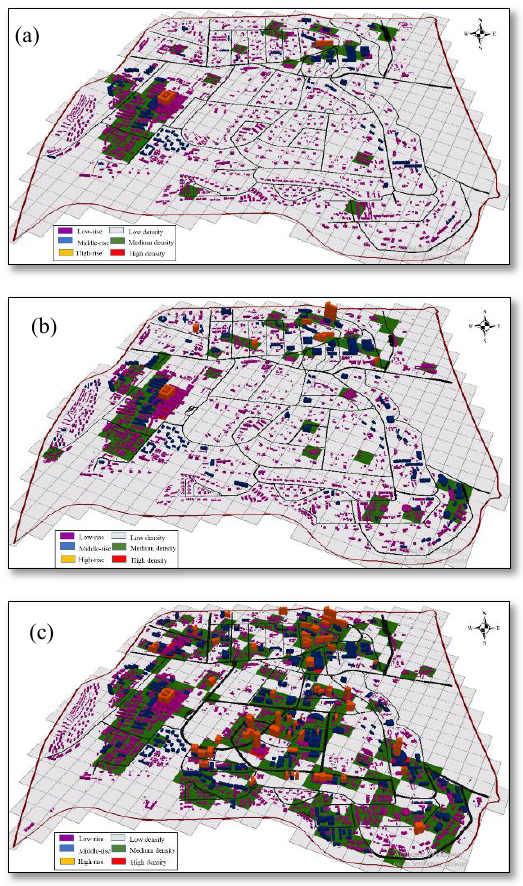
Figure 4: Building height and BVD distribution in 1978 (a), 1998 (b) and 2017 (c) Table 4: Mean GCR, BVD , height and road width from 1978 to Changes in built-up density in the area is expressed in terms of 2017 GCR and BVD. In 1978 low density GCR and BVD in Upper Hill was at 96.64% and 94.51% respectively while high density GCR and BVD was at 0.18% and 0.88% respectively (Figure 4a). High density GCR and BVD is located at Kenyatta National Hospital which is an institutional land use in the west. Open and recreational spaces are concentrated in the eastern and south-western parts of Upper Hill. By 1998, low density GCR and BVD was at 89.7% and 90.3% respectively while high density GCR and BVD was at 0.71% and 1.42% respectively. High density BVD expanded to the northern part of Upper Hill whose land use is commercial